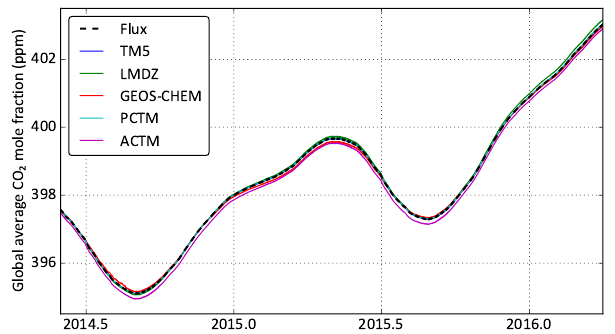
Figure 1. Time series of the global average CO 2 mole fraction ex- pected from the true flux scenario (bold black dashed line) and cal- culated from the individual model outputs (colored lines). The flux scenario only provides increments of the mole fraction, so these in- crements were added to the initial mole fraction of TM5 to calculate the black